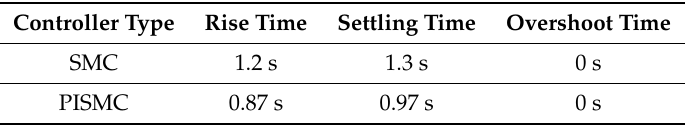
Table 3. Time domain specifications.